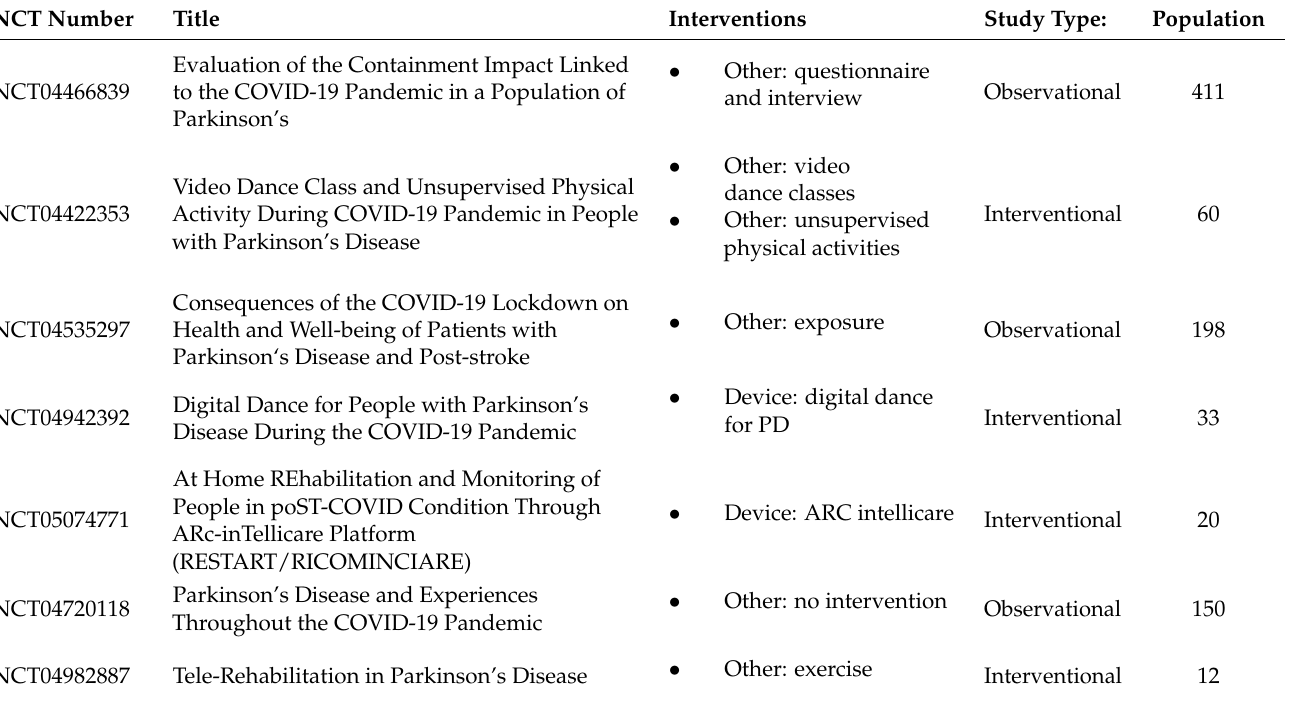
Table 1. The clinical trials that satisfied all the previous filtering criteria/PRISMA steps selected for qualitative synthesis were included in our